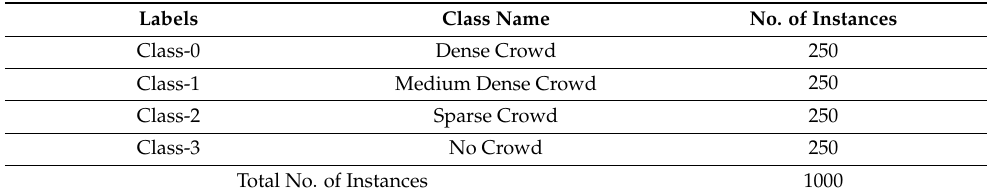
Table 1. Dataset